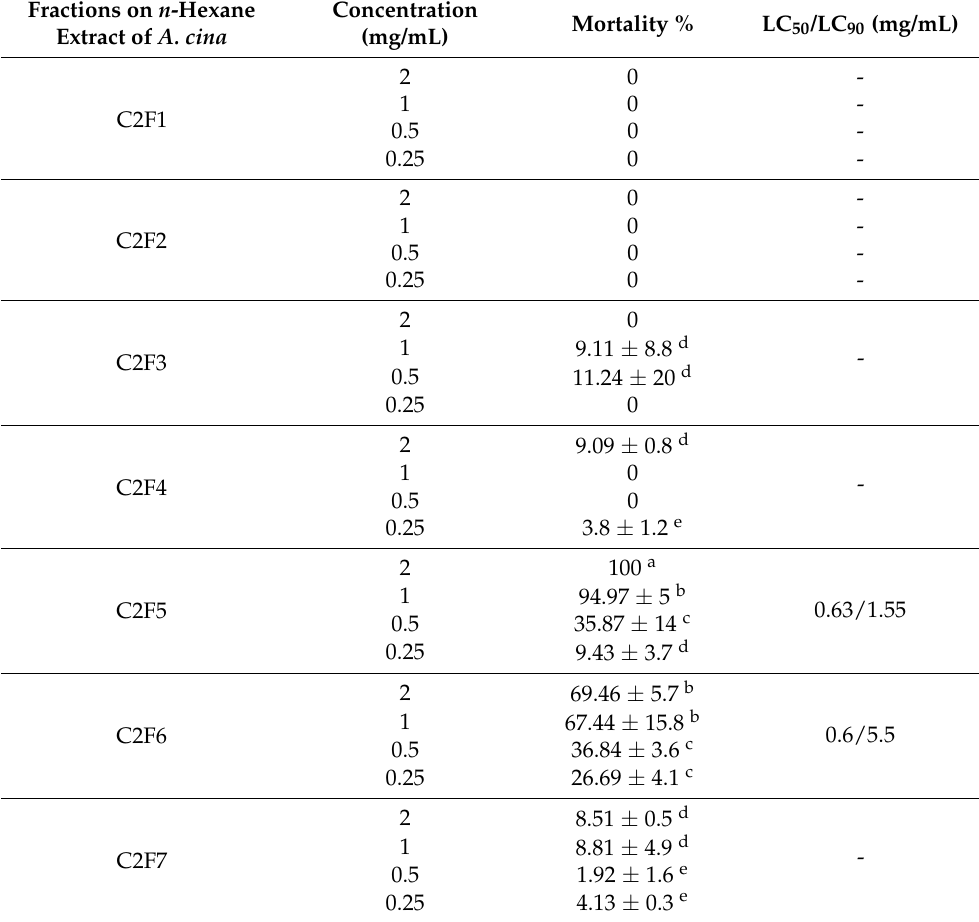
Table 3. Mortality percentage and lethal-effect concentration (LC 50 and LC 90 ) of compounds obtained from A. cina n -hexane extract C1F5 fraction after 24 h of exposition. Fractions on n -Hexane Concentration Extract of A. cina